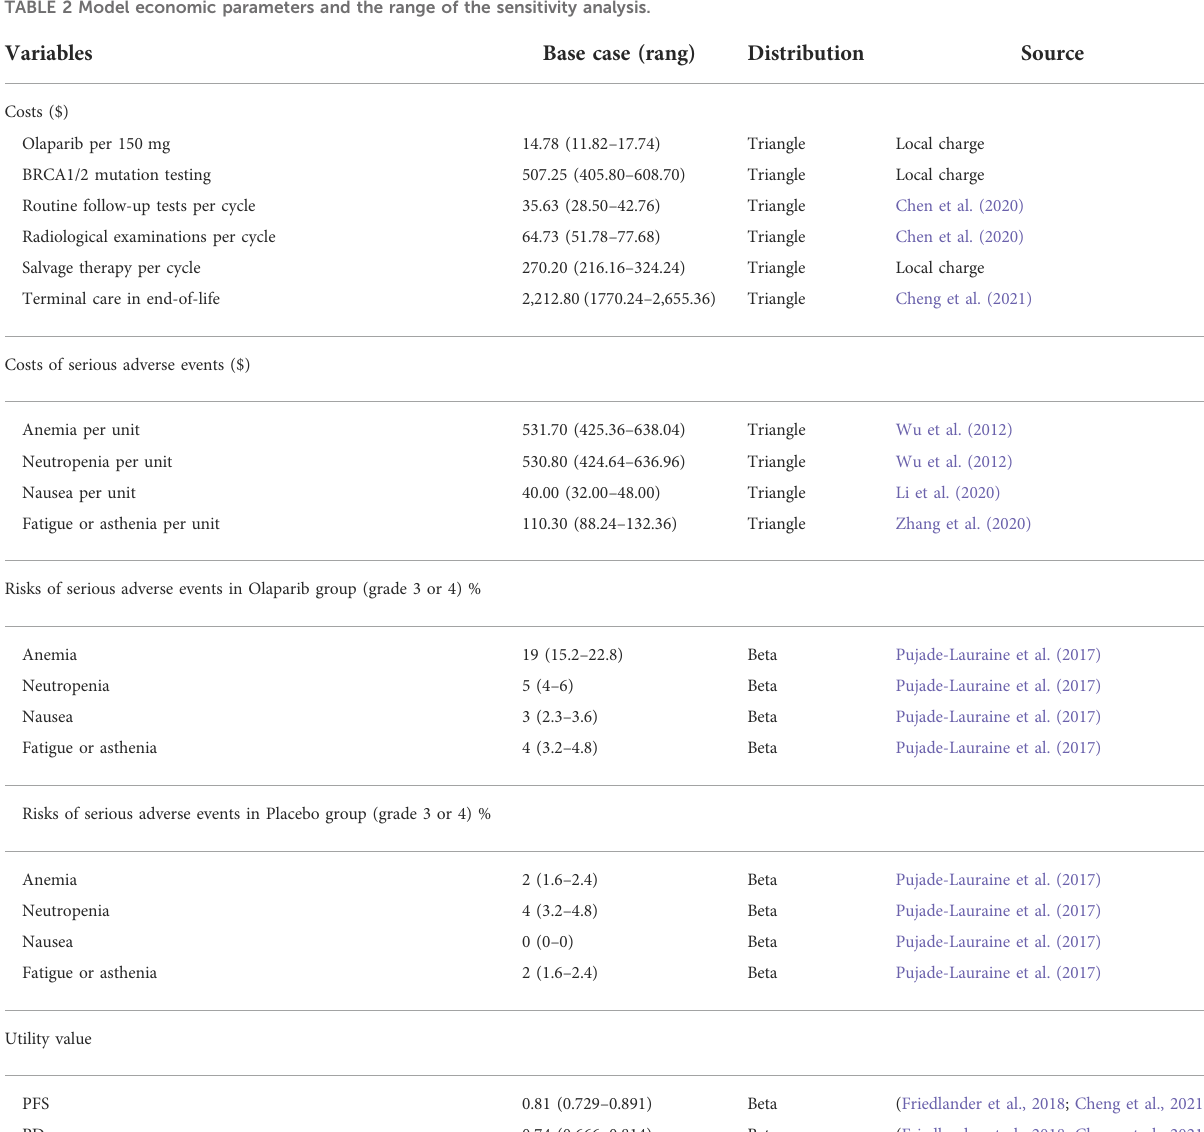
TABLE 2 Model economic parameters and the range of the sensitivity